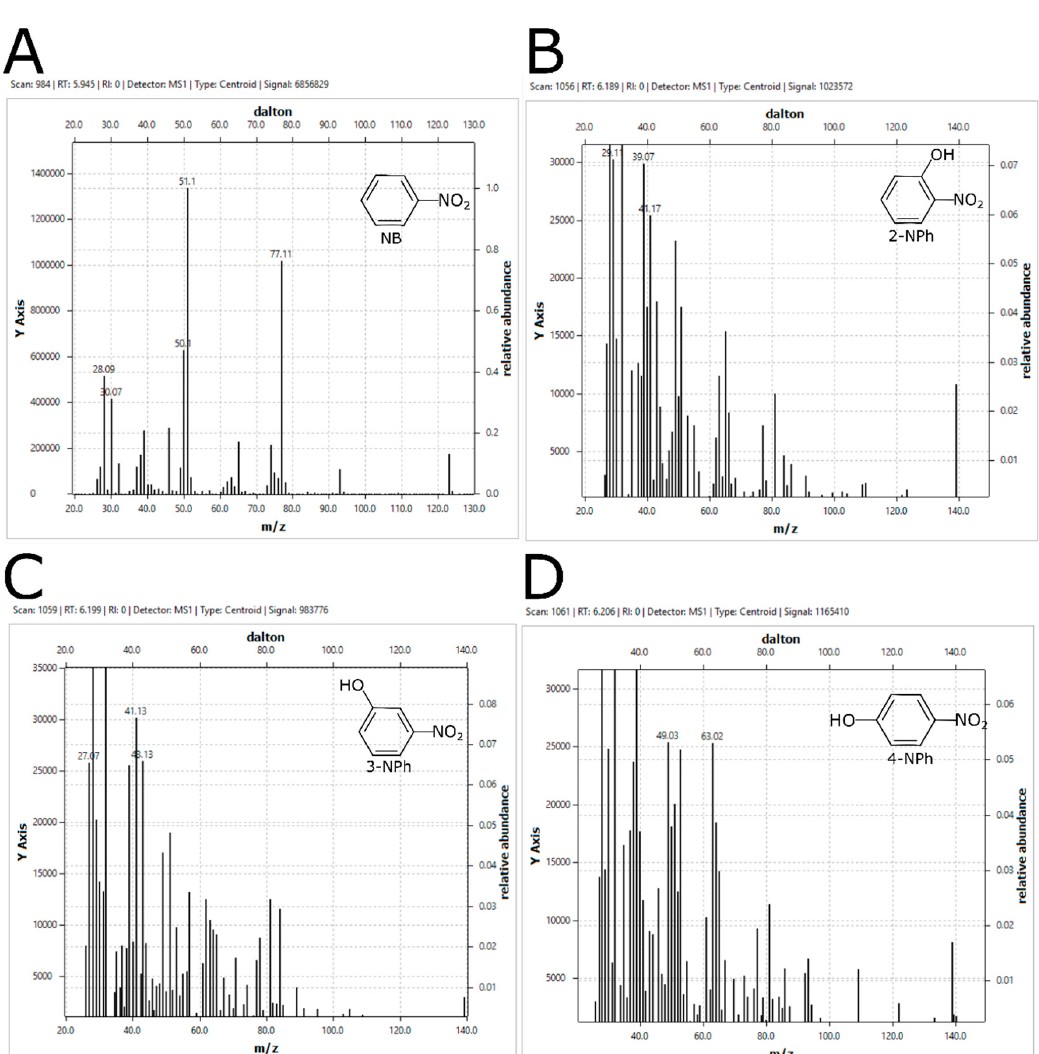
Figure 9. Mass spectrum (MS) for the detected molecules of the NB photocatalysis extracts. ( A ) NB, ( B ) 2-nitrophenol (2-NPh), ( C ) 3-nitrophenol (3-NPh) and ( D ) 4-nitrophenol (4-NPh) (NPs).